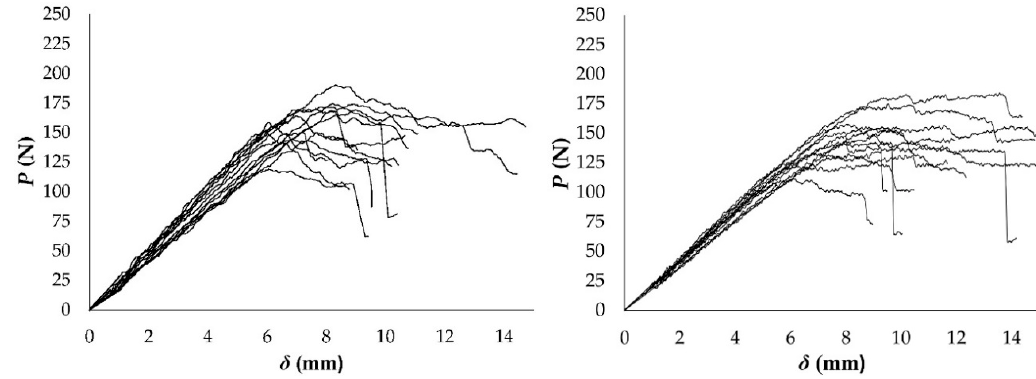
Figure 3. P - δ curves from DCB test in RL (left) and TL (right) propagation systems.